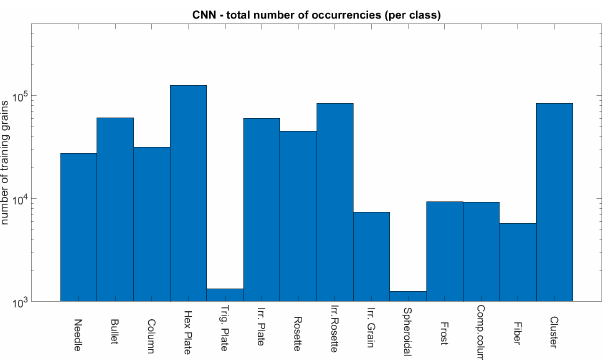
Figure 20. Total number of particles classified in the 14 classes for years 2014–2015.